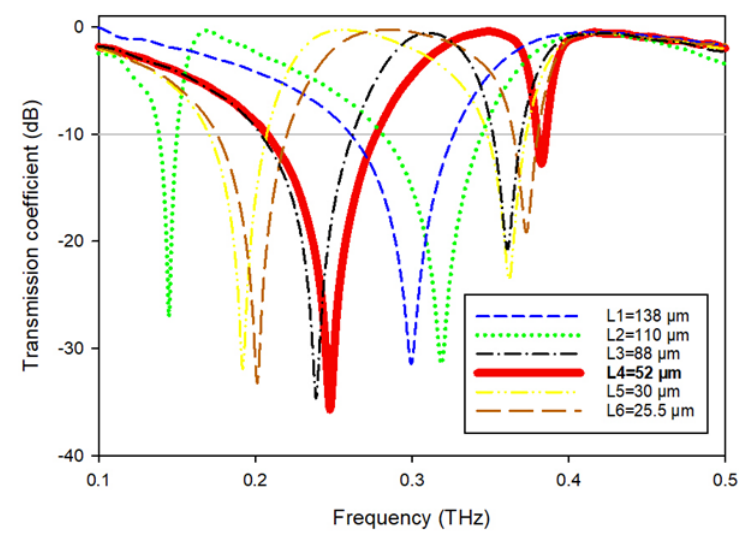
Figure 7. Transmission coefficients while varying the slotted-strip line’s length.